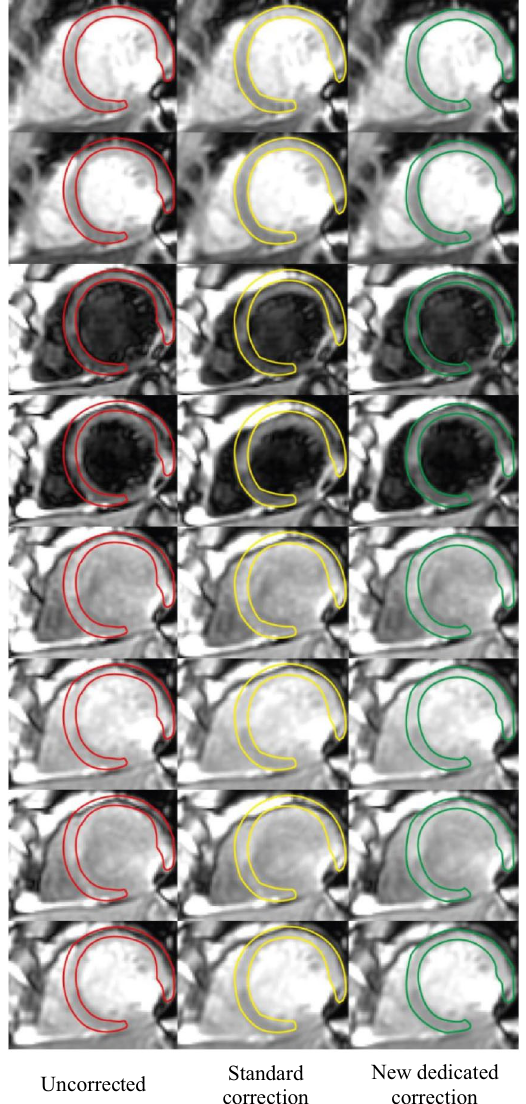
Figure 6. Example MOLLI series, processed with each of the three motion correction approaches discussed in this study. The myocardial delineation of the first frame is overlaid on all frames for reference. Notice how, in this case, the standard correction approach has resulted in misregistration of frames 3 to